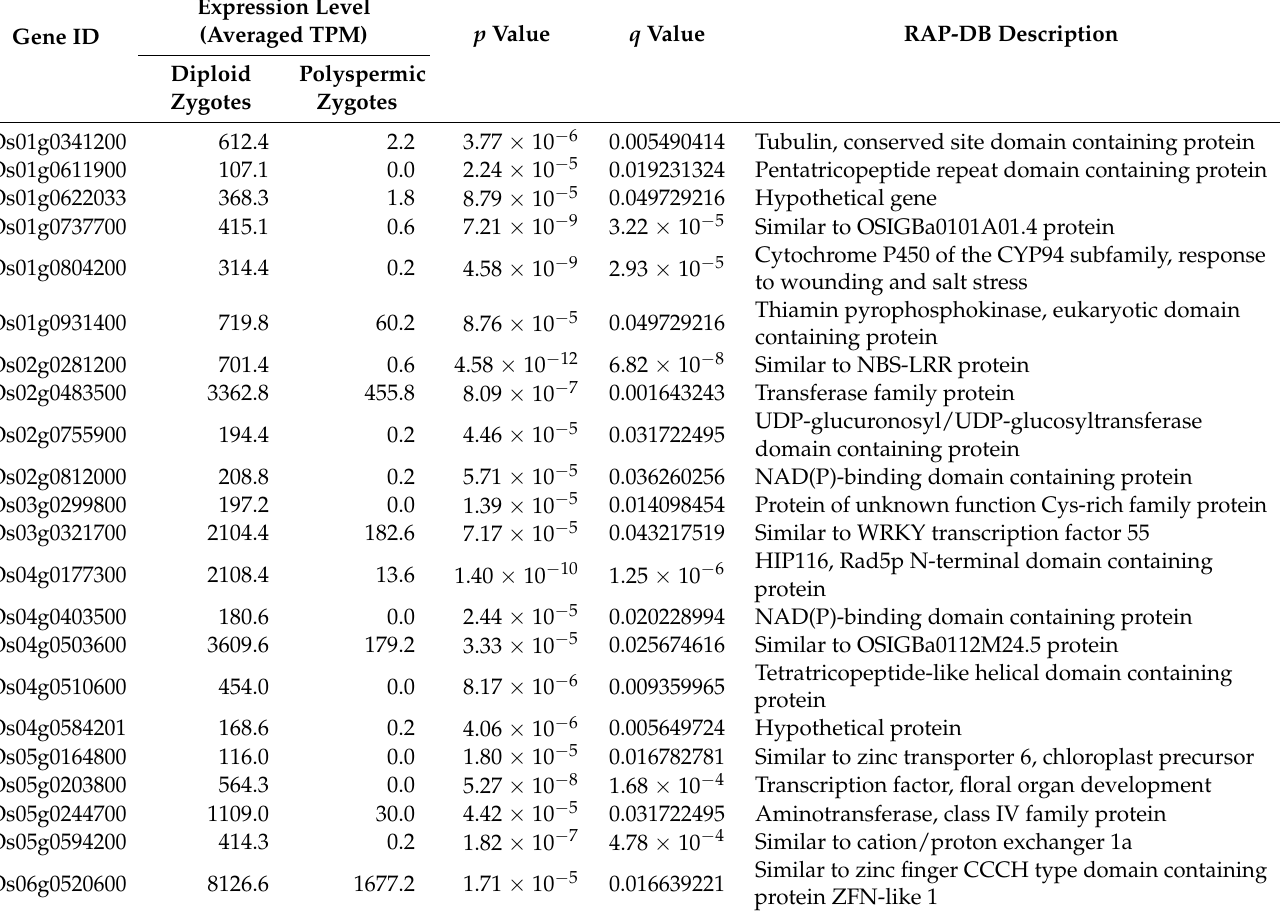
Table 3. Identified genes with putatively down-regulated expression levels in polyspermic